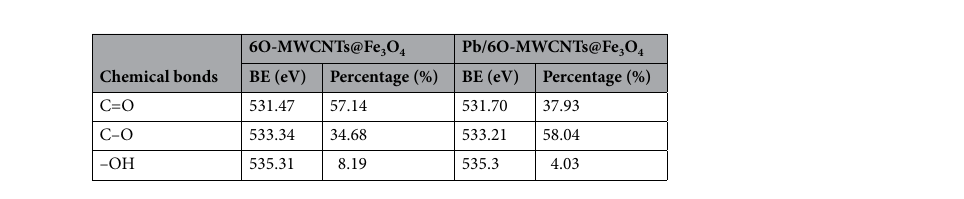
Table 1. Peak positions and relative abundance from curve fitting of